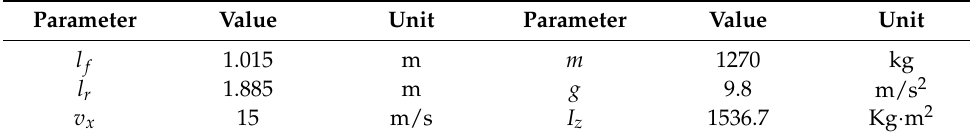
Table 1. Vehicle simulation